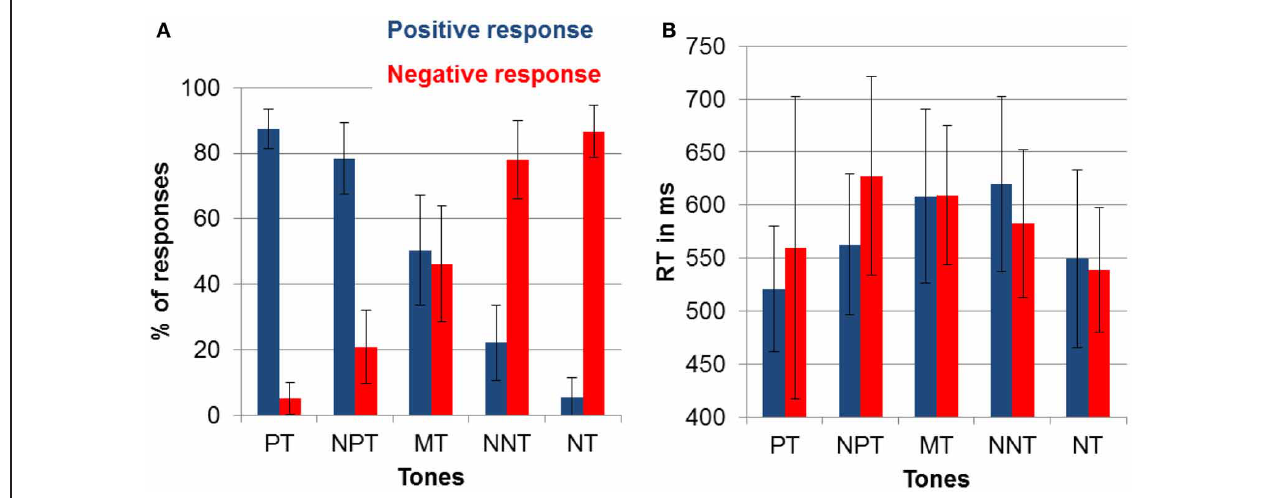
FIGURE 2 | (A) Percentage of chosen responses (and SD) to avoid punishment (negative response) and obtain reward (positive response) for each of the five tones. (B) Mean reaction times (and SD) to the five tones.